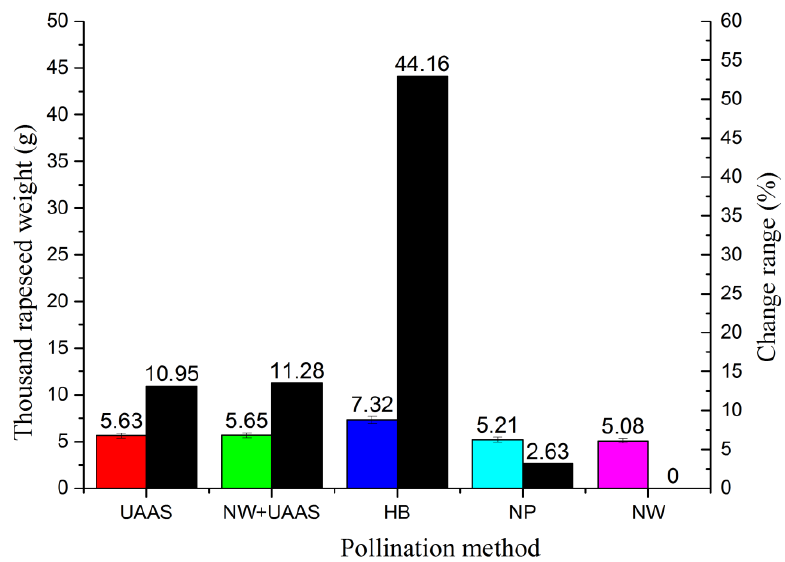
Figure 9. The TRWs of different pollination areas and TRW change range. Note: UAAS—unmanned agricultural aerial system; NW+UAAS—natural wind + UAAS; HB—honeybee; NP—no pollinators; NW—natural wind; TRW—thousand-rapeseed weight.